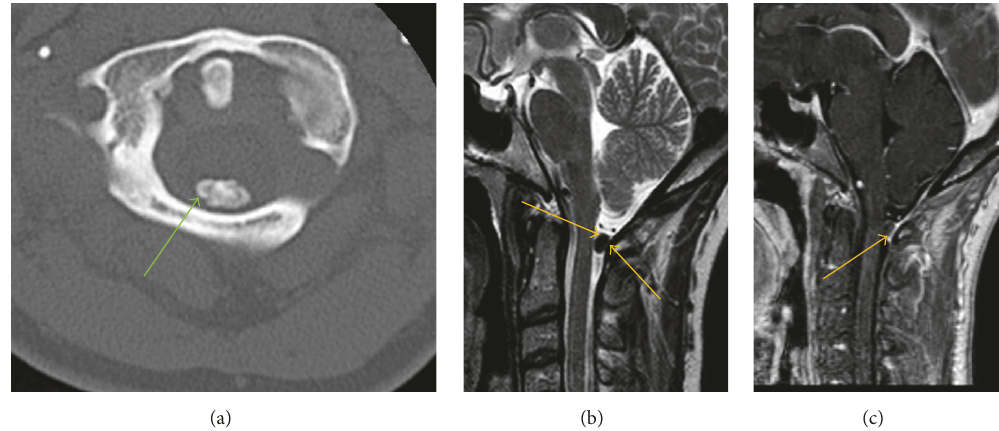
Figure 6: Axial NECT of cervical spine (Figure 6(a)) demonstrates a calcified well-marginated lesion (green arrow) within posterior aspect of central canal at C1 level. On sagittal T2WI (Figure 6(b)) and sagittal postgadolinium (Figure 6(c)) MR images, this extramedullary intradural lesion (orange arrows) is noted to be T2 hypointense and mildly rim enhancing, respectively, causing effacement of posterior thecal sac and abutment of cervical spinal cord at the level of posterior arch of C1. The imaging findings favor a calcified